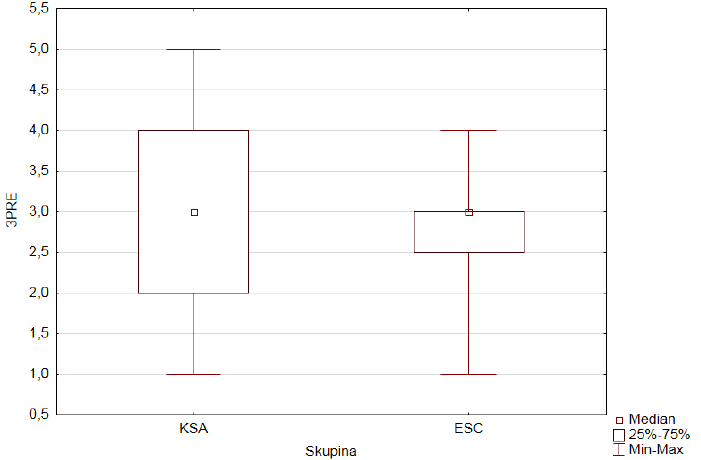
Figure 8. The box graph of the second item of the posttest - 2POST.